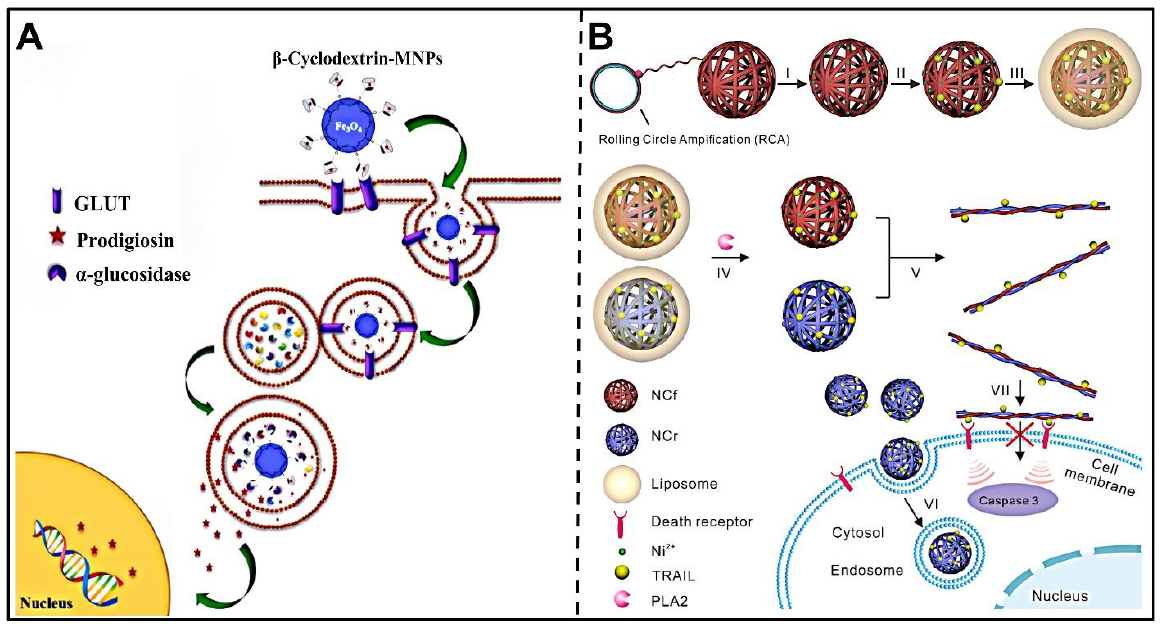
Figure 6. Design and responsive mechanism of enzyme-triggered srNPs. ( A ) Illustration of recogni- tion, transport and α -glycosidase-triggered release of prodigiosin-loaded β -cyclodextrin-MNPs at the tumor site. Reproduced with permission [128]. Copyright 2017, Elsevier. ( B ) Illustration of synthesis and sPLA2-triggered activation mechanism of TRAIL-loaded DNA NCs covered with liposome. Reproduced with permission [120]. Copyright 2016, Elsevier.